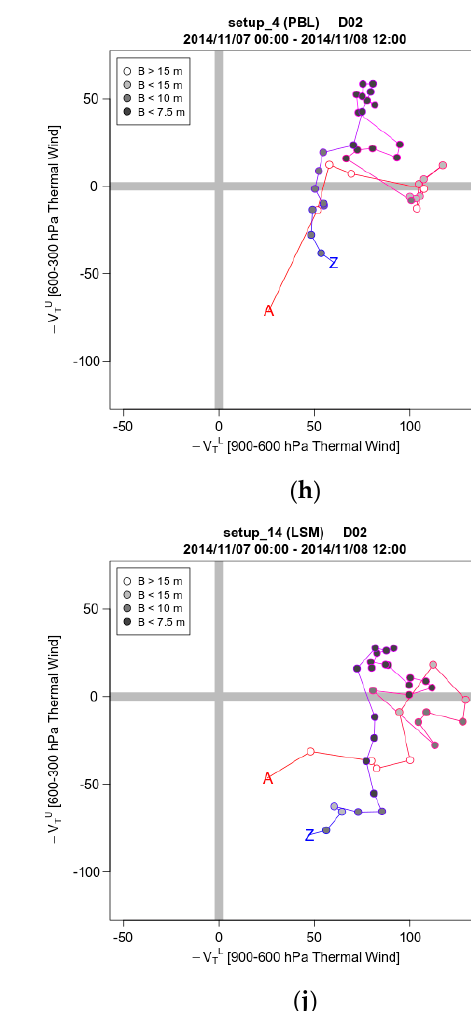
Figure 9. Phase space diagrams of − V TL (900–600 hPa) against − V TU (600–300 hPa) as predicted from control (setup-MAIN) experiment in ( a ) D01 and ( b ) D02 domain. Symmetry B is denoted by the shade of circles.